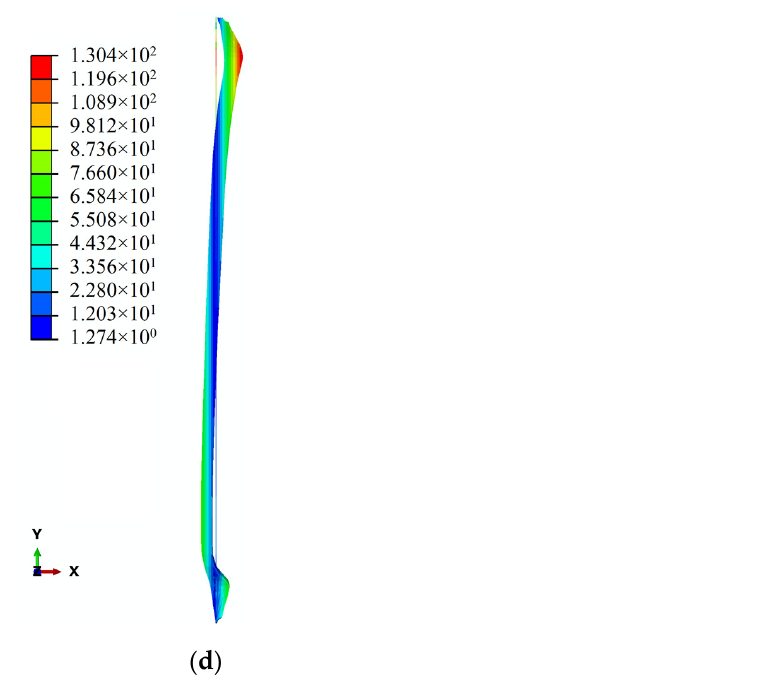
Figure 15. Stress and deformation cloud diagrams of model SPSW-N8: ( a ) stress cloud of bolt holes at the upper end of steel plate under pull monotonic loading (unit: MPa); ( b ) stress cloud of bolt holes at the lower end of steel plate under pull monotonic loading (unit: MPa); ( c ) deformation cloud of steel plate at the end of cyclic loading (unit: mm); ( d ) left-view cloud of deformed and undeformed steel plate at the end of cyclic loading (unit: mm).